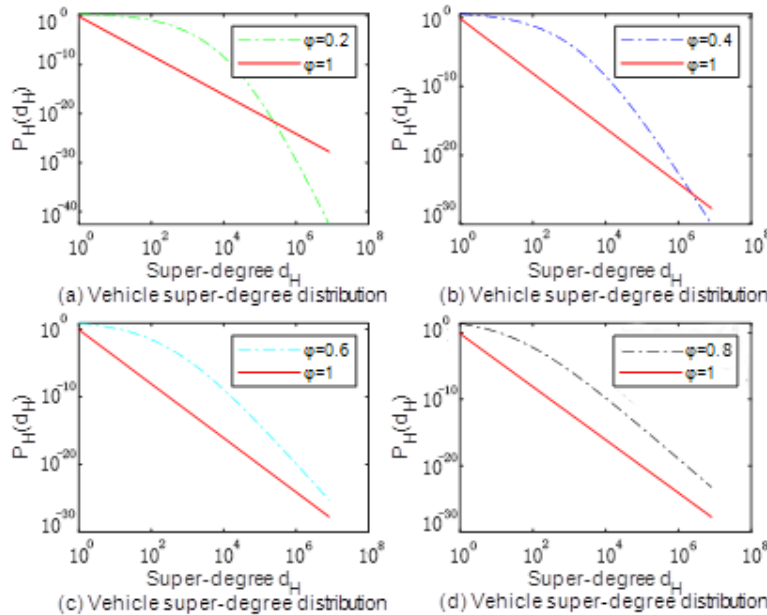
Figure 2. The characteristics with different φ .